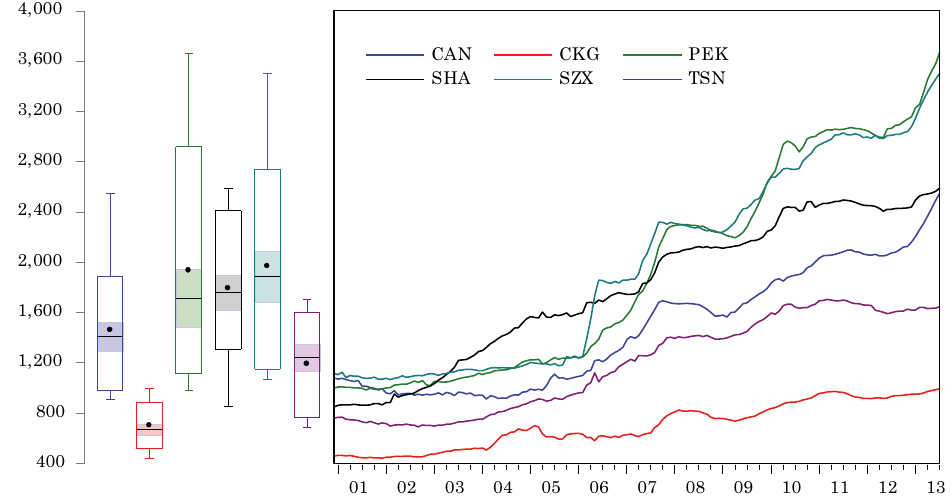
Fig. 2. Plots of regional house prices